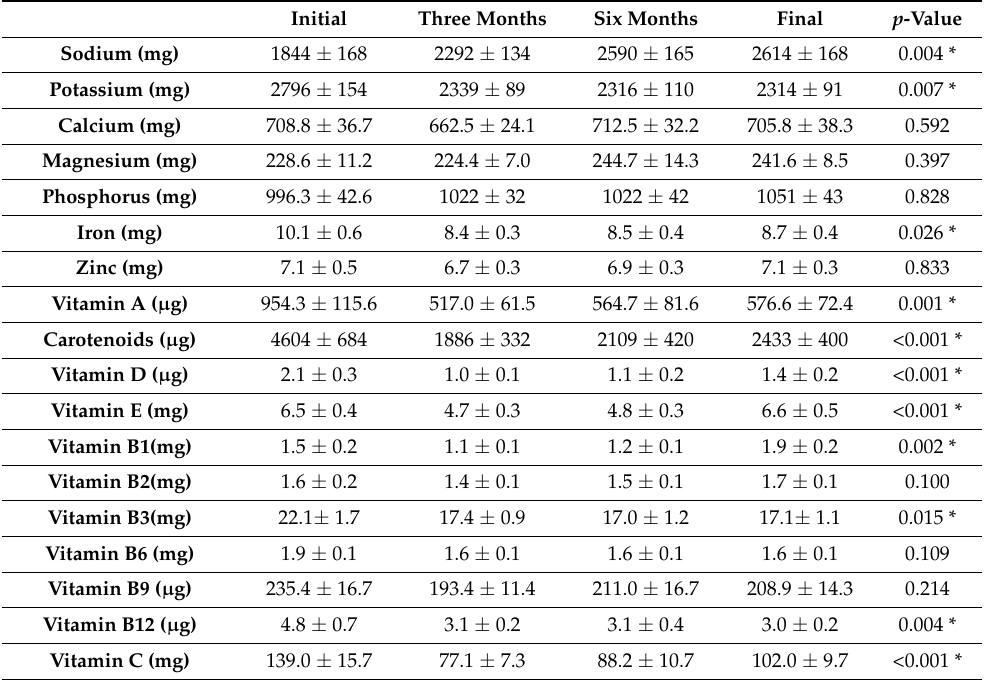
Table 2. Changes in daily energy, macronutrient, and water intakes during the study.